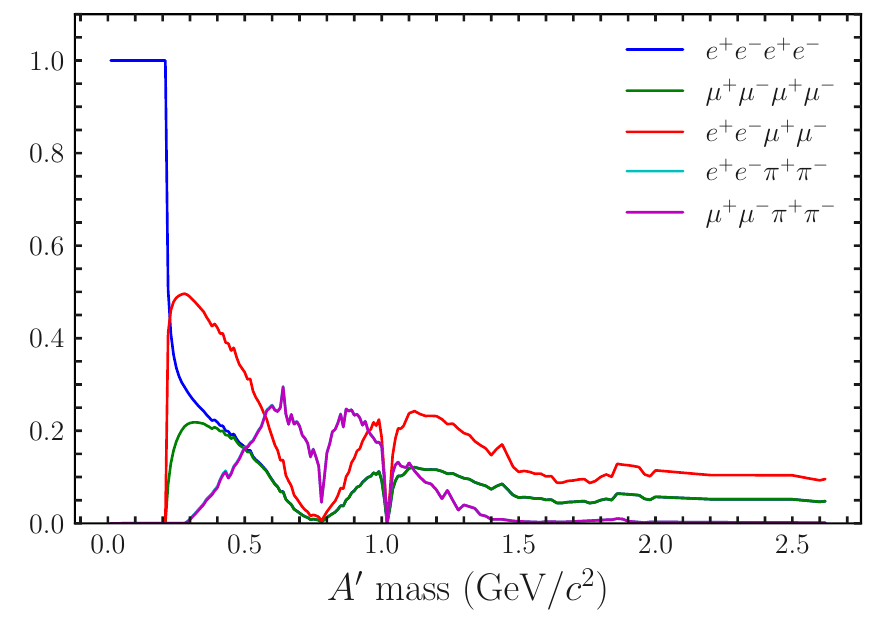
Figure 4 . B ( B 0 → A 0 A 0 → f ) / B ( B 0 → A 0 A 0 ) distributions for each final state and dark pho- ton mass. e + e − π + π − and µ + µ − π + π − distributions are almost the same for the whole region. e + e − e + e − and µ + µ − µ + µ − distributions are the same and e + e − µ + µ − distribution is twice that of four-electron or four-muon final states in the region m A 0 > 0 . 5 GeV /c 2